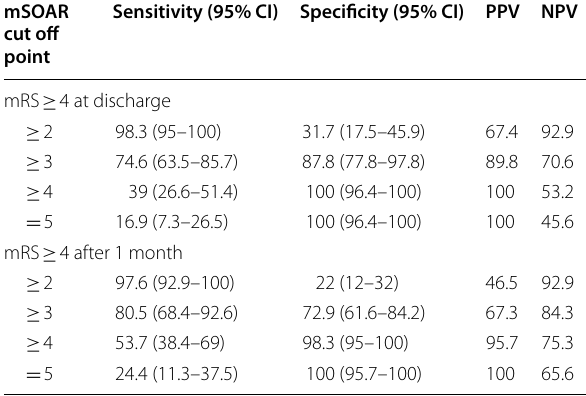
Table 1 Items of mSOAR score